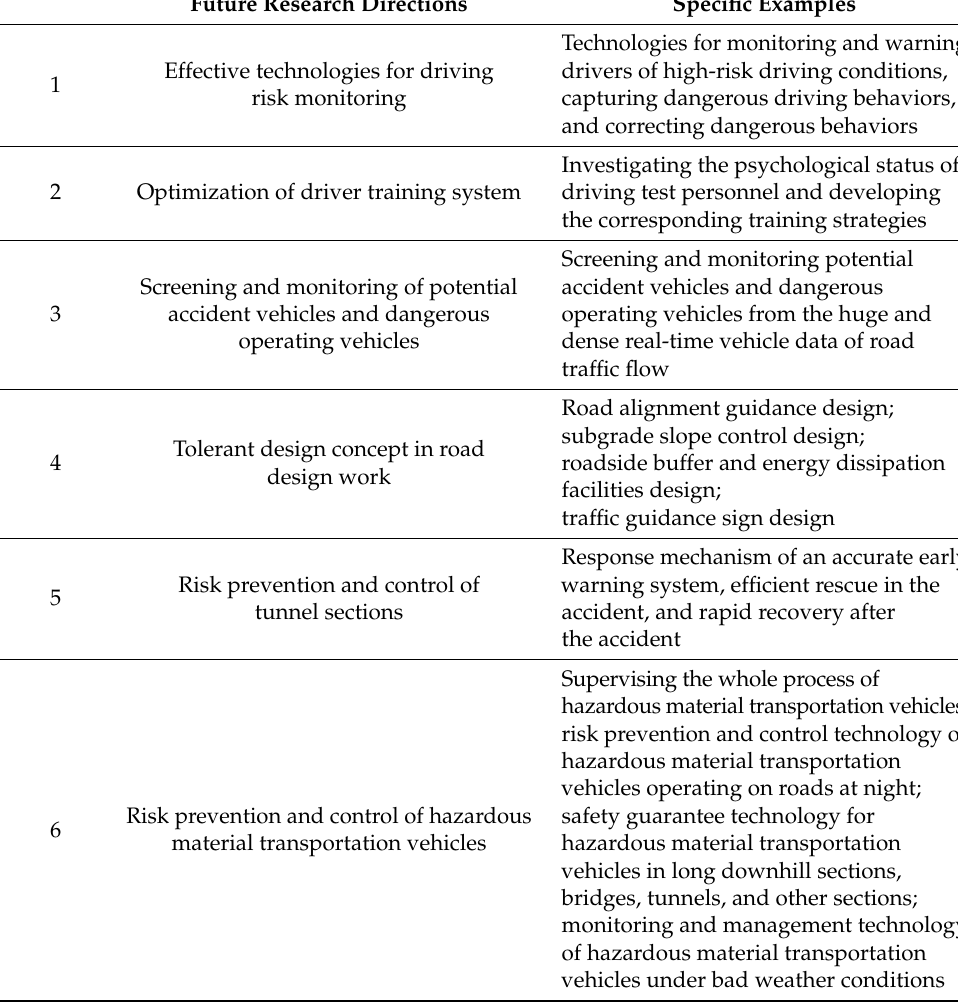
Table 2. Future research directions based on